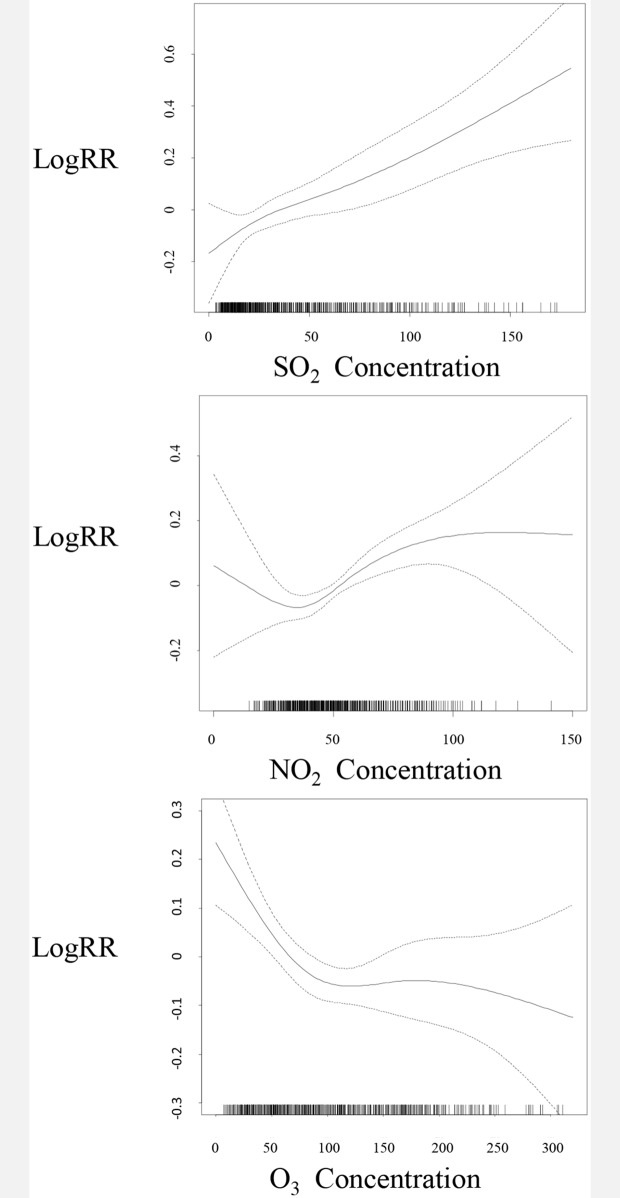
Smoothing plots of air pollution. X-axis is the concentration of pollutants (μg/m3).The estimated mean percentage of change in daily outpatient-visits for epilepsy is shown by the solid line, and the dotted lines represent twice the point-wise standard error.